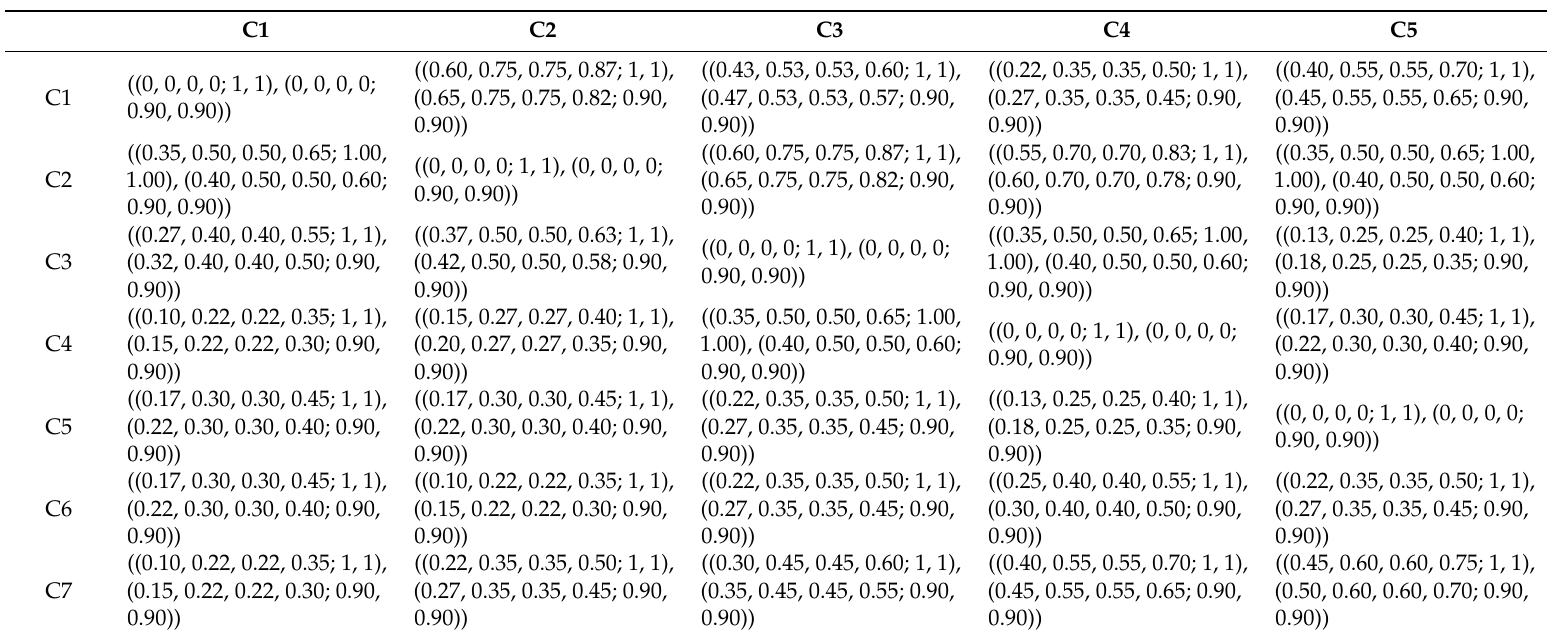
Table A4. Fuzzy direct relation matrix for the